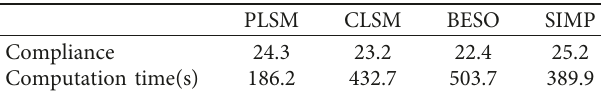
Table 3: Comparison of results of different methods in form finding of through arch